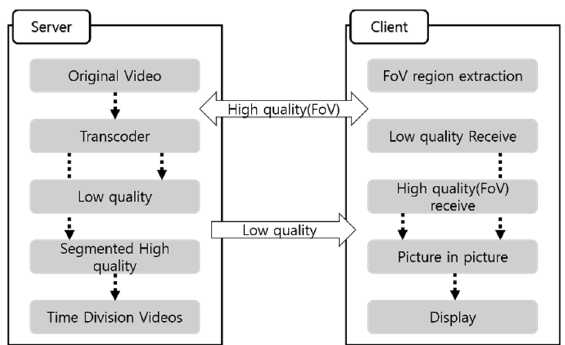
Figure 10. FBF network configuration diagram.